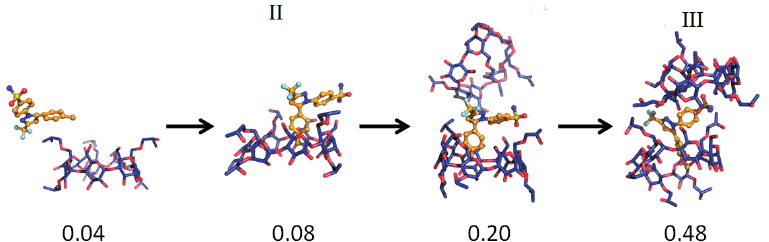
Figure 4. The key steps in the formation of the 1:1 (Structure II) and 1:2 (Structure III) CCB/HP- β -CD inclusion complex.